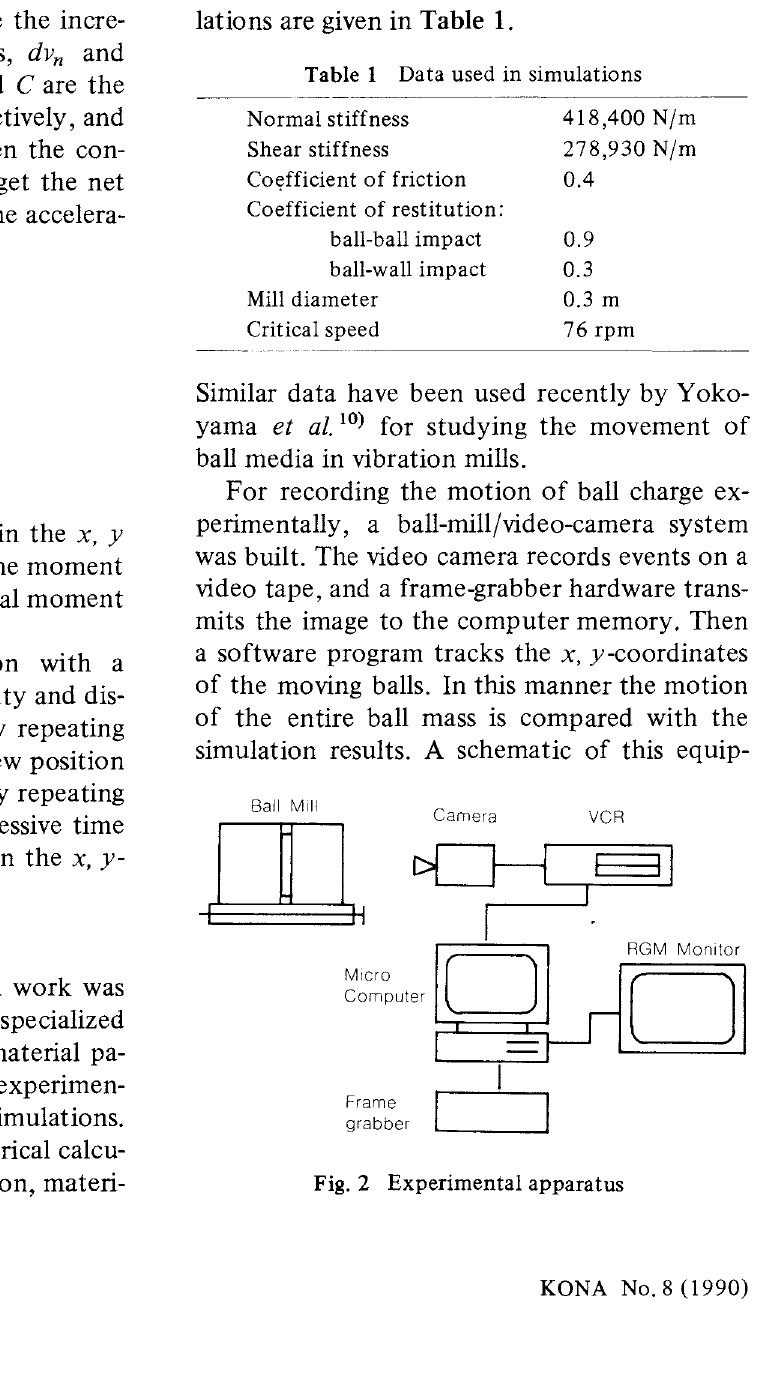
Table 1 Data used in simulations